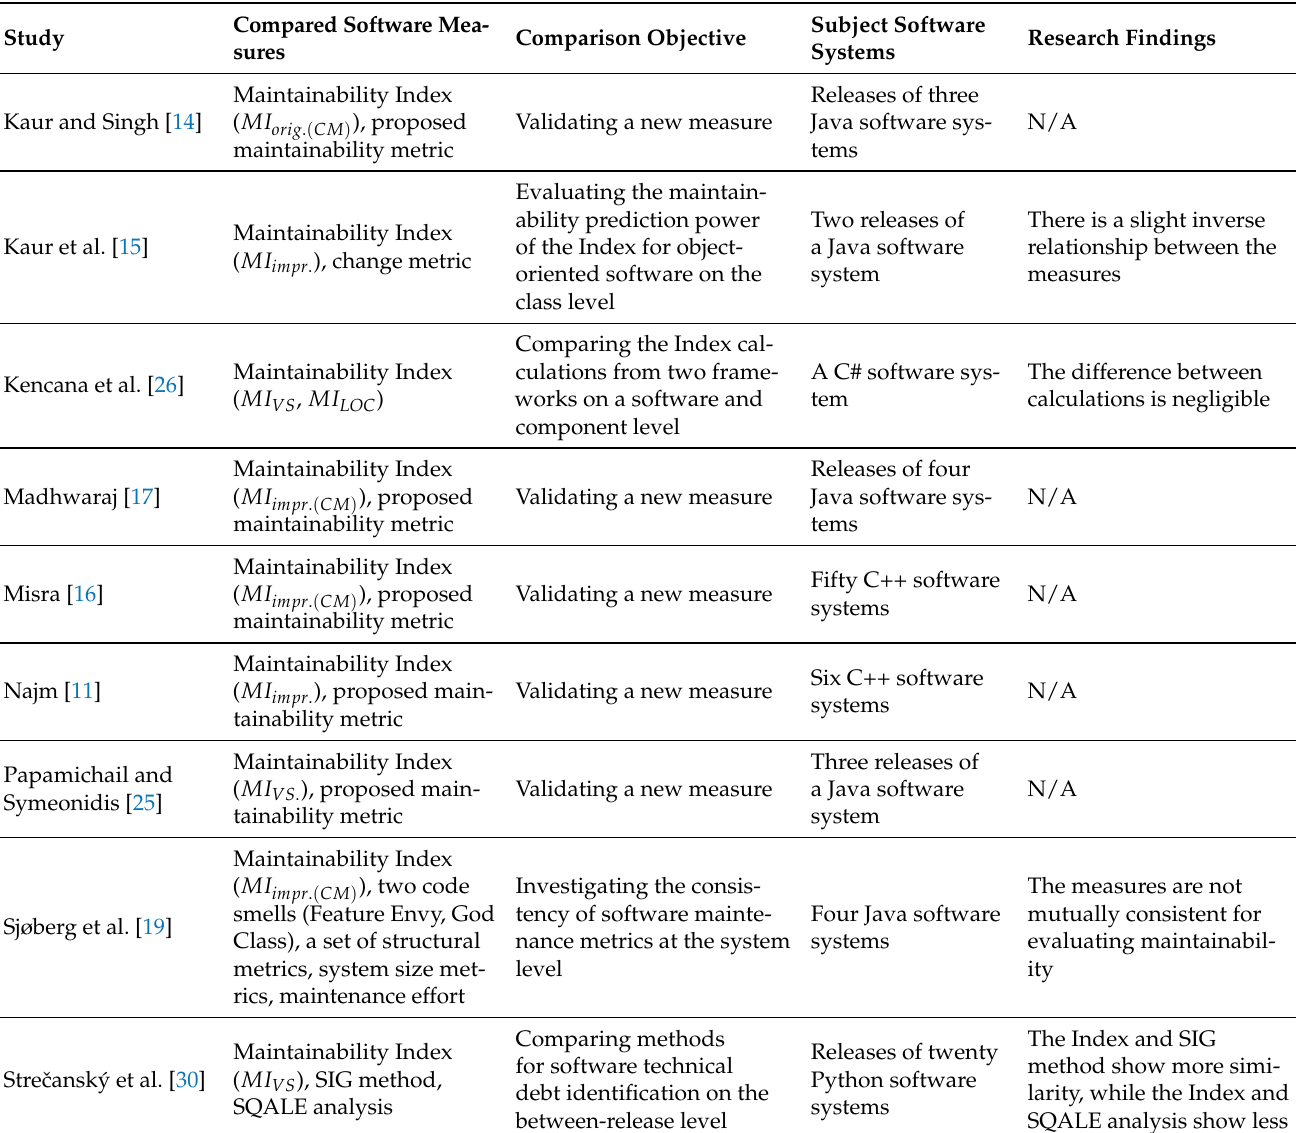
Table 3. Overview of related